Question: Which kind of chart has been used to present this data?
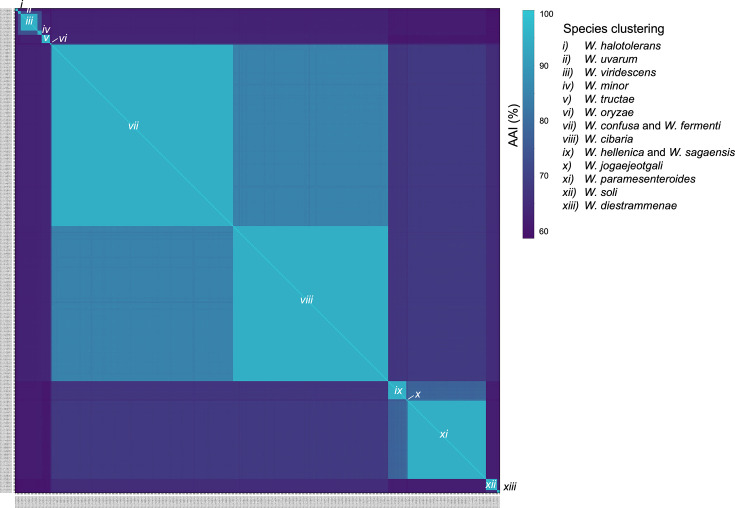
Answer: heatmap